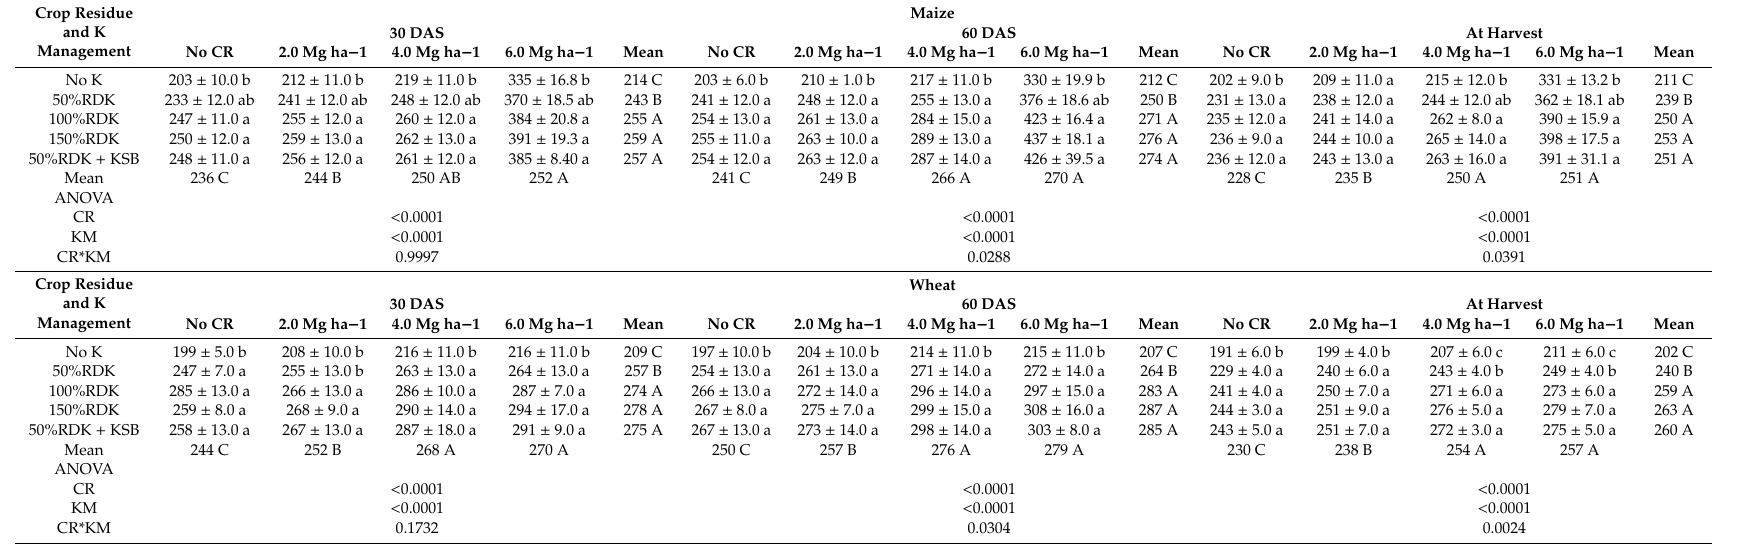
Table 4. Crop residue and potassium management practices on exchangeable potassium (kg ha − 1) of maize and wheat soil at di ff erent crop growth stages under zero tillage maize–wheat system (pooled data of two